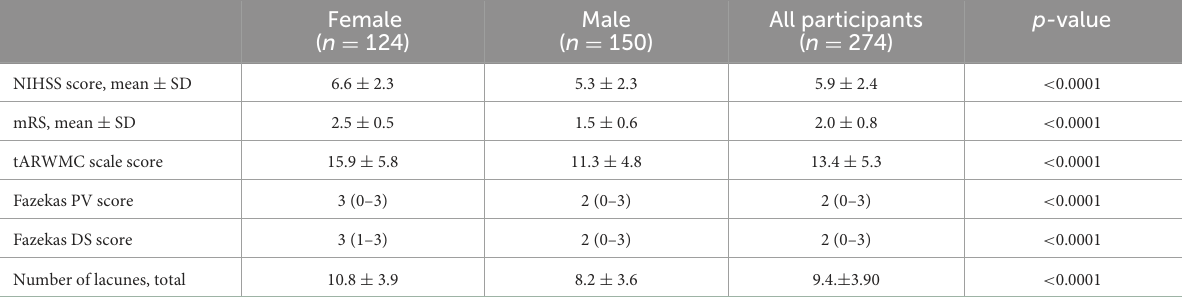
TABLE 2 Baseline clinical and neuroimaging characteristics of patient